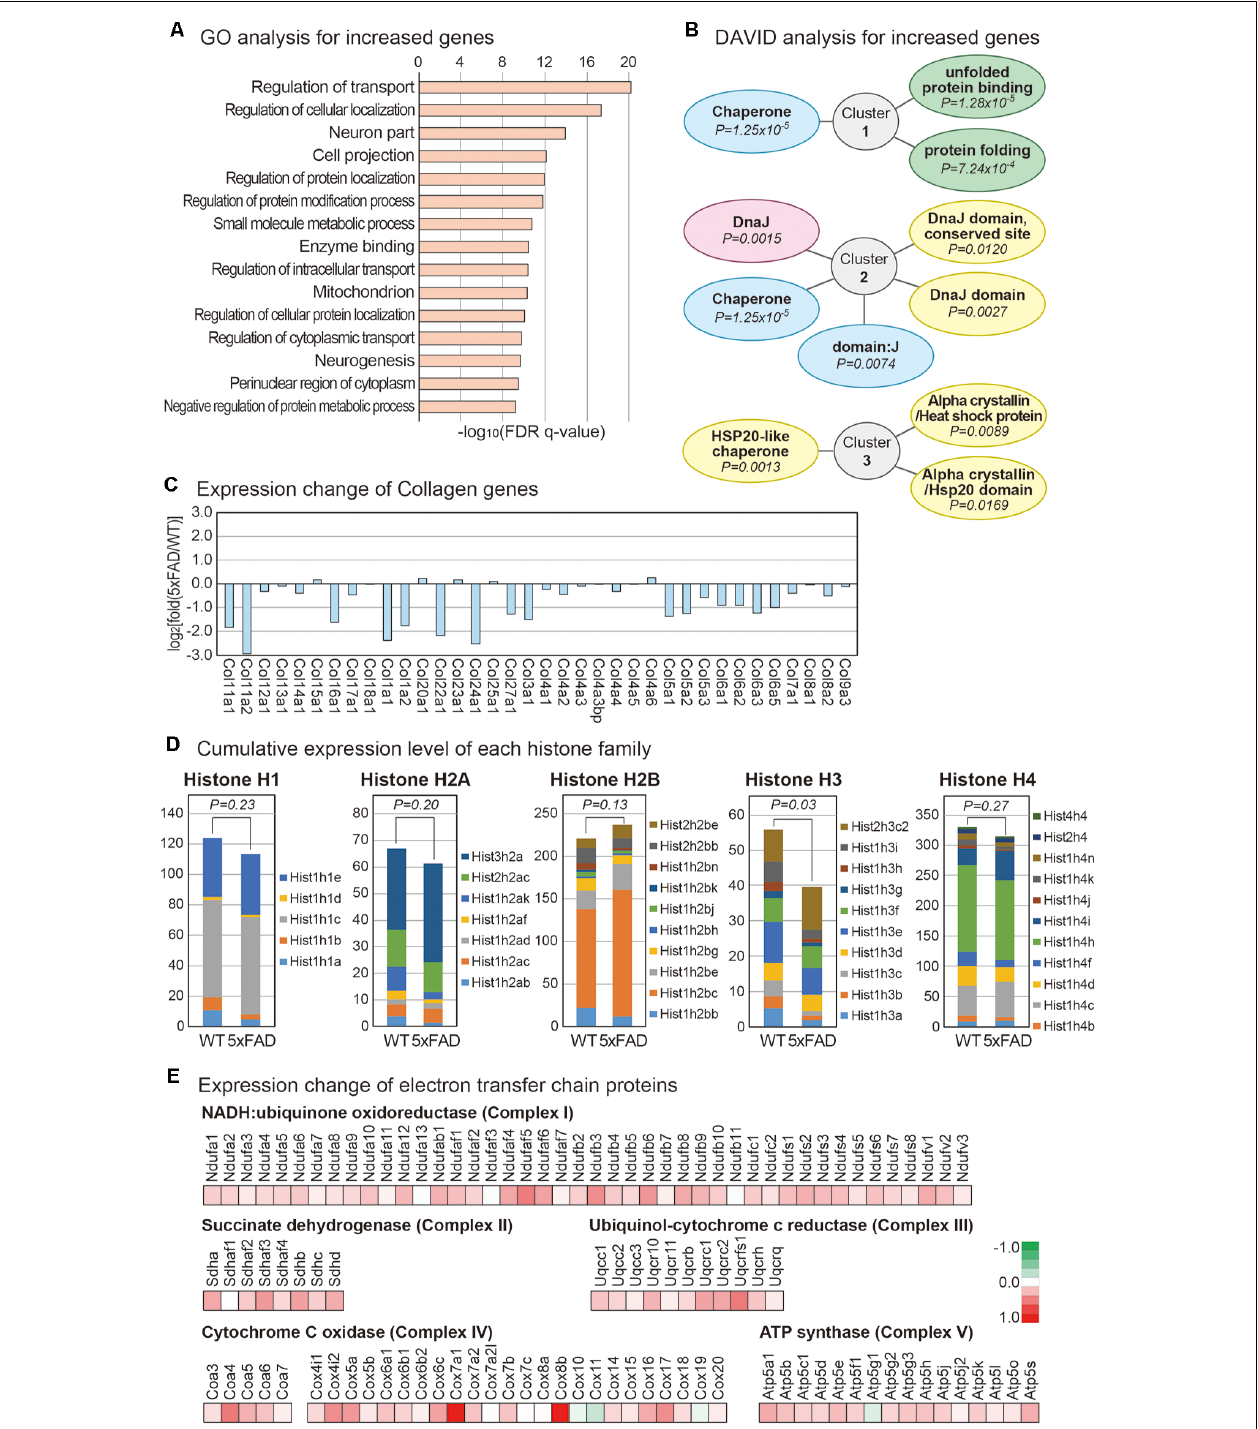
FIGURE 2 | Analysis of mRNAs changes in the mouse pineal gland with AD. (A) Gene ontology (GO) analysis of increased protein-coding mRNAs in the pineal gland from 5xFAD vs. wild type mice. The top 15 GO terms based on the false discovery rate (FDR) q -value are shown. (B) Database for Annotation, Visualization and Integrated Discovery analysis for increased protein-coding mRNAs. The top three enriched clusters are visualized. (C) Expression changes in the collagen genes are shown. (D) Expression of histone gene groups. The sum of fragments per kilobase of transcript per million mapped reads value for the members of each histone group was calculated. A one-tailed t -test was applied to calculate the P -value. (E) Expression changes for the members of the electron transfer chain in mitochondria. The expression changes for members from each mitochondria complex between the pineal glands from the wild type and 5xFAD groups are shown.